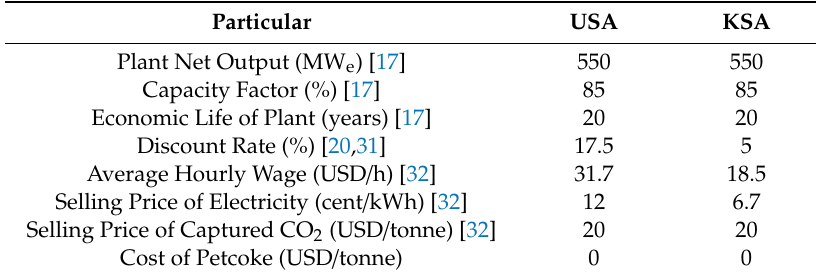
Table 2. Assumptions for the economic model.